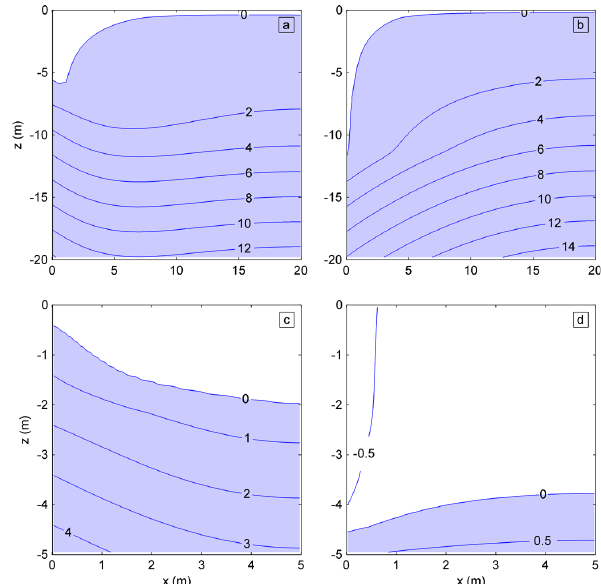
Fig. 5. Pressure head distribution in cross sections of varved clays. Width of each graph is half the distance between two fissures ( L) , height is fissure depth ( d) . Fissures are located at x = 0. Blue area is saturated. (a) Large system at t = 0 days, (b) large system at t = 272 days, (c) small system at t = 0 days, (d) small system at t = 230